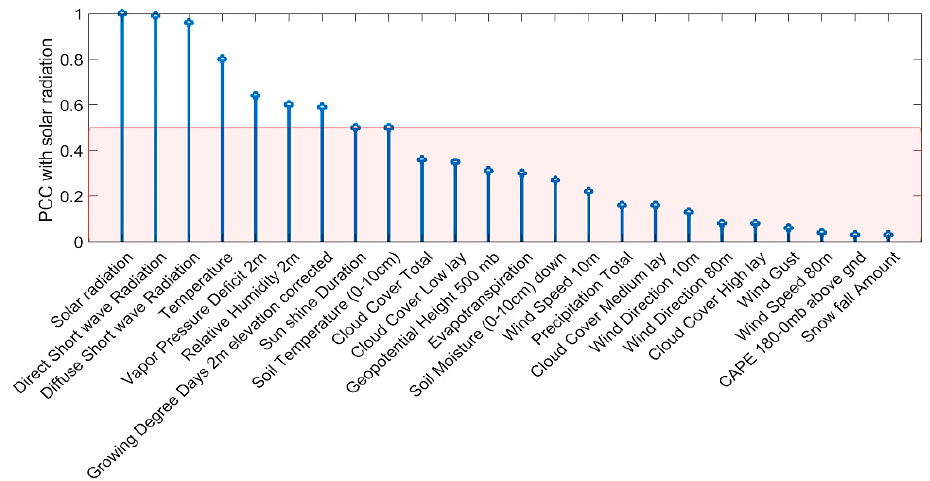
Figure 4. PCC between different meteorological parameters and solar radiation, ranked according to the PCC value (the threshold for parameters’ selection corresponds to the red line). the PCC value (the threshold for parameters’ selection corresponds to the red